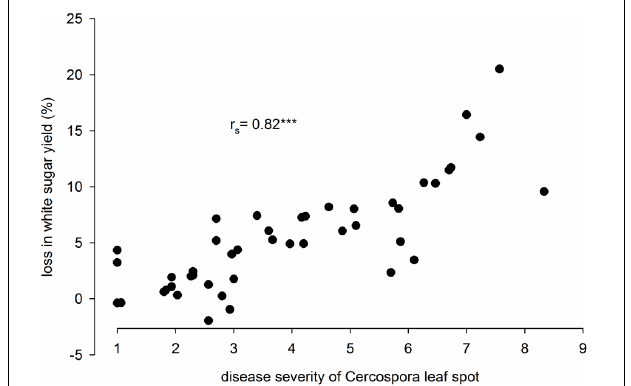
FIGURE 2 | Disease severity (DS) of Cercospora leaf spot and relative loss in white sugar yield (WSY) in 45 environments in Germany, 2014–2016; mean of 15 varieties. Relative loss in white sugar yield (WSY) is the yield difference between healthy and non-treated fungicide levels as percentage of WSY in the healthy level. DS was rated in the non-treated plots on a 1–9 scale (1: no infection, 9: very high infection; BSA, 2000); r s = Spearman’s rank correlation coefficient, ∗∗∗ P ≤